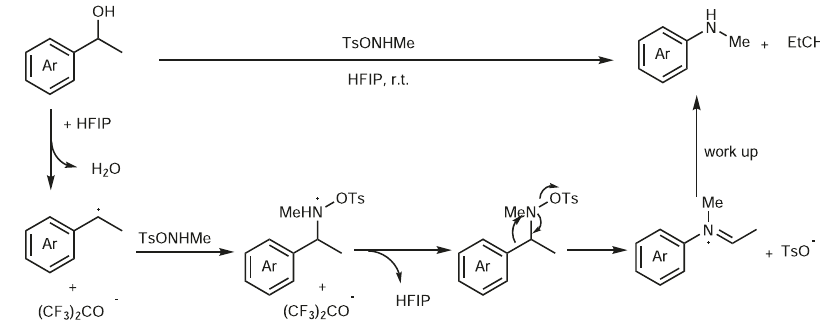
Fig. 8 Proposed mechanism of the C – C amination. HFIP hexa fl uoroisopropanol, Ts